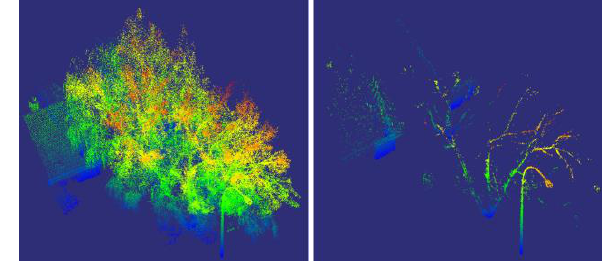
Figure 4. Before (Left) and after (Right) the introduced vegetation removal method apply to the point